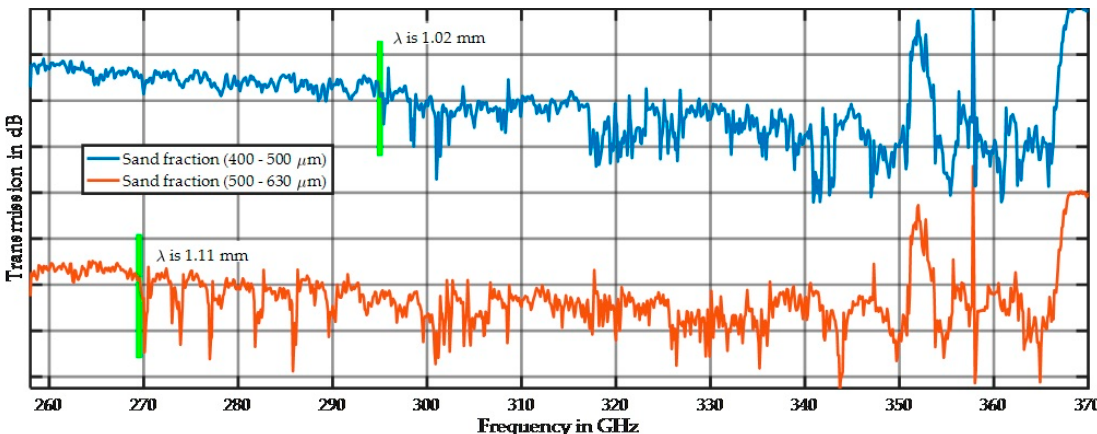
Figure 13. Spectral behavior of two sand fractions in the 10 mm sample holder. Stronger spiking begins around the half-wavelength (green line).